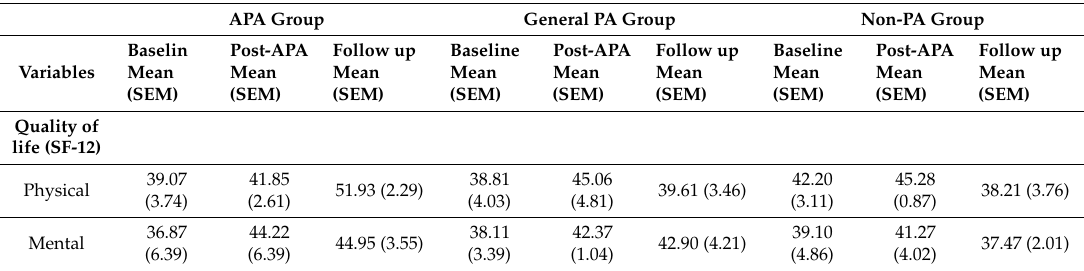
Table 5. Mean scores of the quality of life questionnaire (SF-12) at the baseline, post-APA, and follow up (two years post-APA) for each of the three study groups.